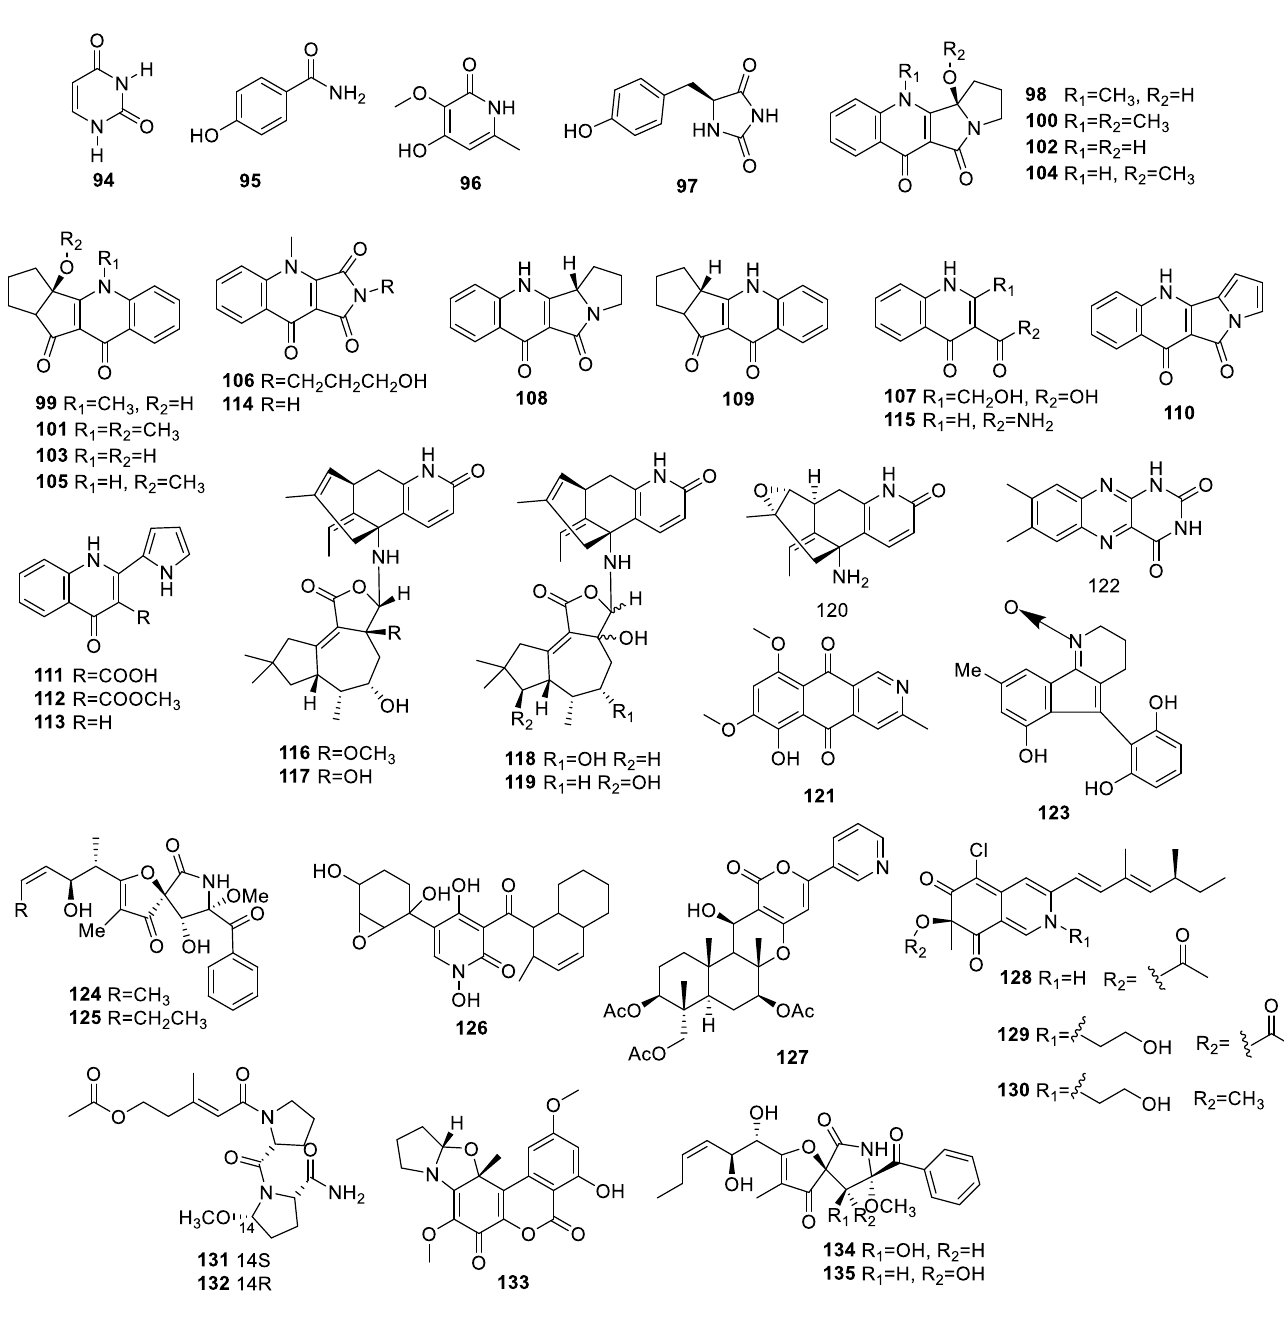
Figure 4. Chemical structures of other alkaloids ( 94 – 135 ).